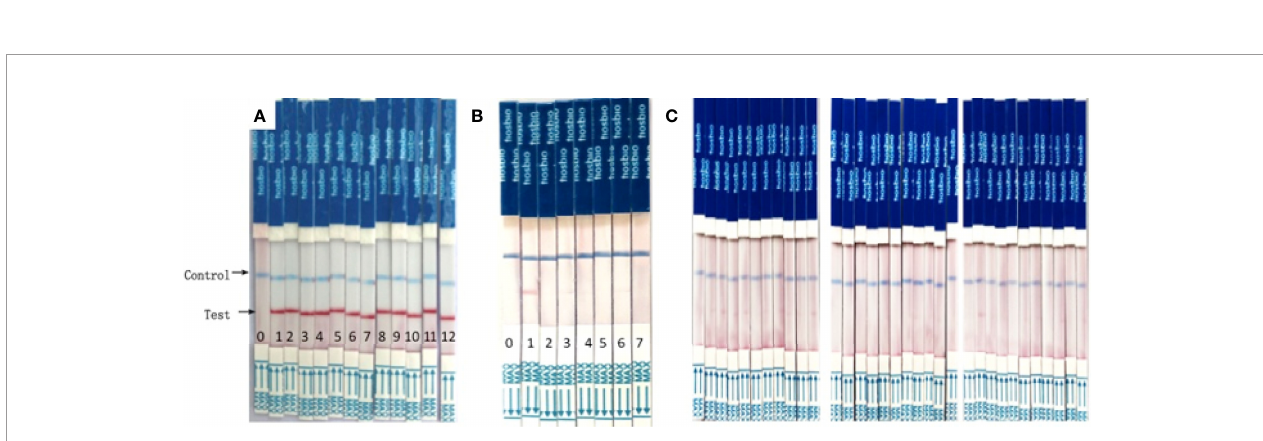
FIGURE 5 | RAA/LFD results for a selection of clinical samples. (A) malaria patients. 0- H 2 O, 1-12 DNA extracted from malaria patients. (B, C) . foreign university student blood donors. In (B) , 0-negative control, H 2 O, 1- asymptomatic PCR positive donors, 2-6, other PCR negative blood donors. In (C) . The results of RAA-LFD were all